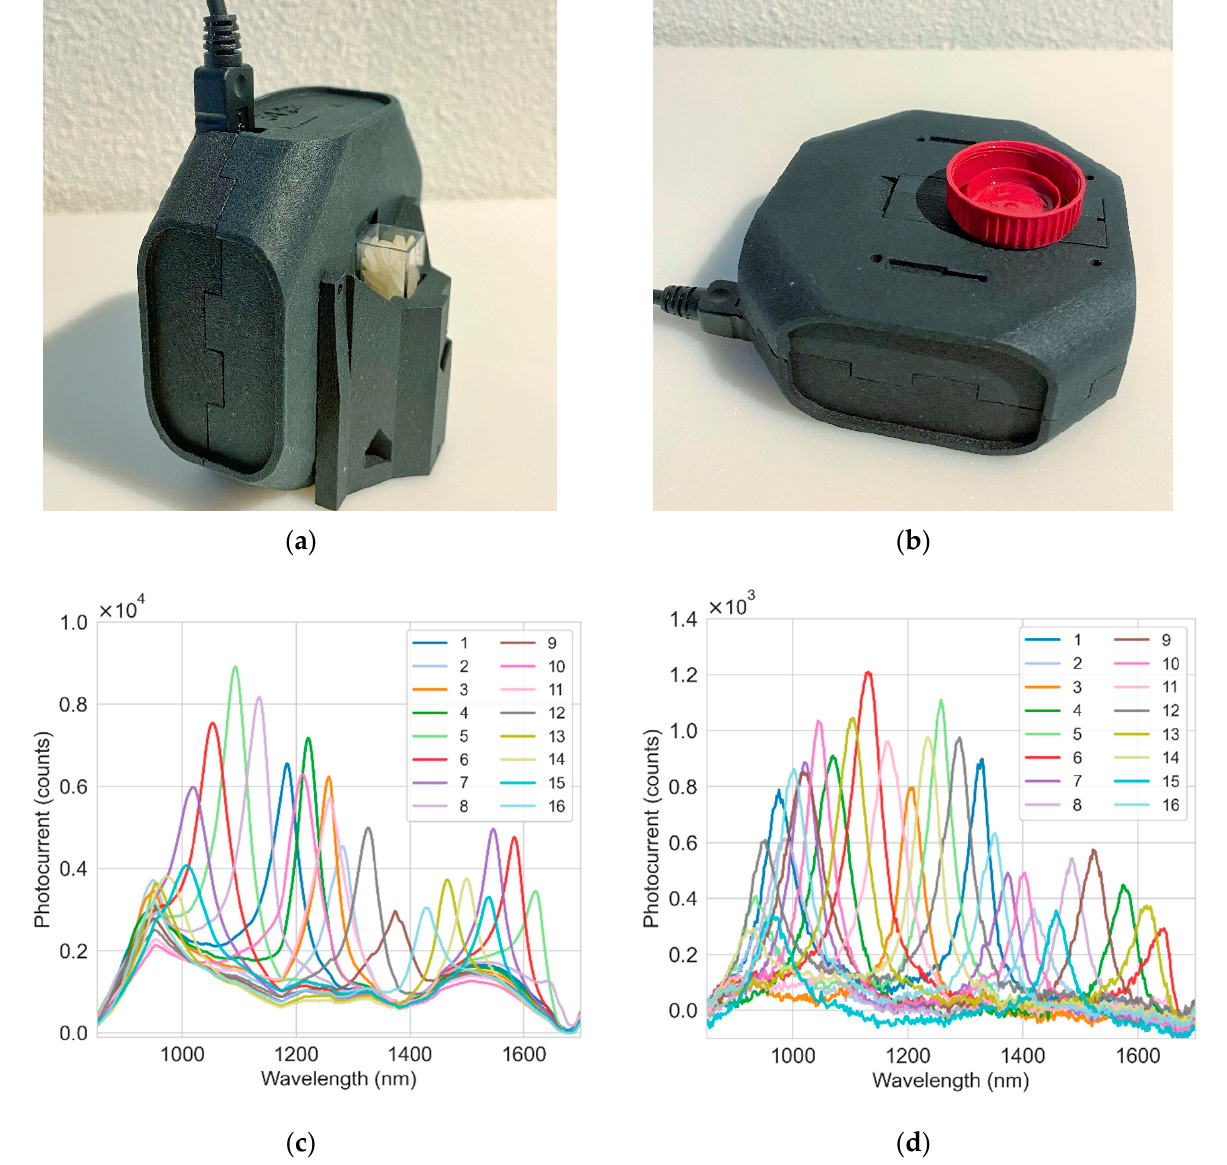
Figure 1. The standalone handheld SpectraPod modules (physical dimension: 8.2 × 8.2 × 3.4 cm 3 ) and their response curves. ( a ) SpectraPod with cuvette holder attachment used in the moisture quantification experiment; ( b ) the basic SpectraPod module for acquiring reflectance measurements from plastic samples. The response curves of the SpectraPod containing chip 1 ( c ) and chip 2 ( d ).